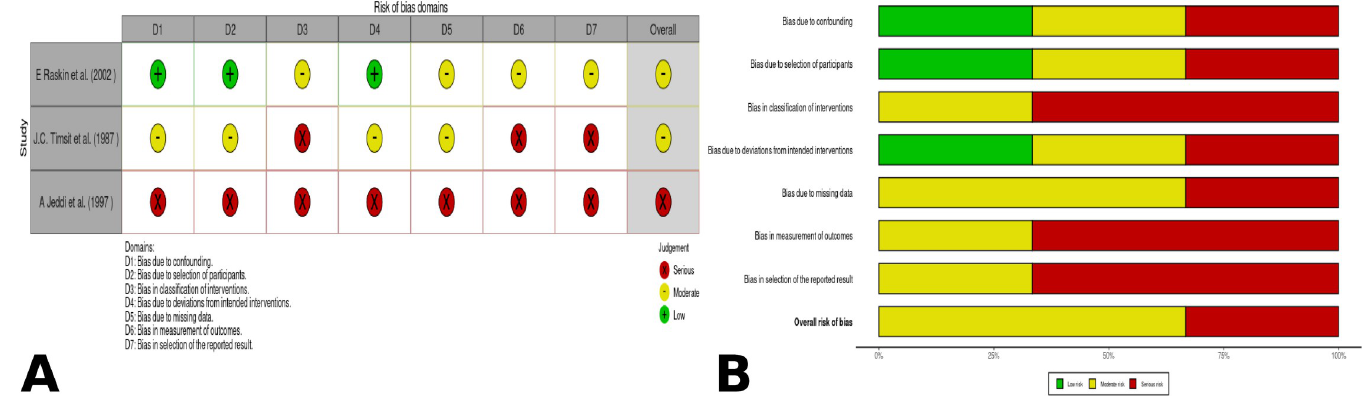
Fig 3. Summary across the Risk of Bias in Non-Randomized Studies of Interventions (ROBINS-I) tool [19]. (A). ROBINS-I risk of bias summary of non-randomized control trials traffic light; (B). ROBINS-I risk bias graph across non-randomized controlled trials.